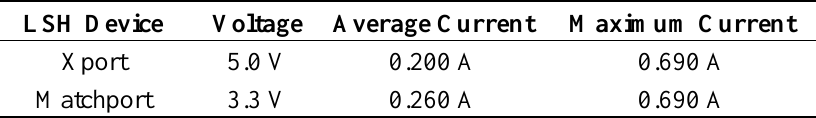
Table 7. LSH device comparison table.